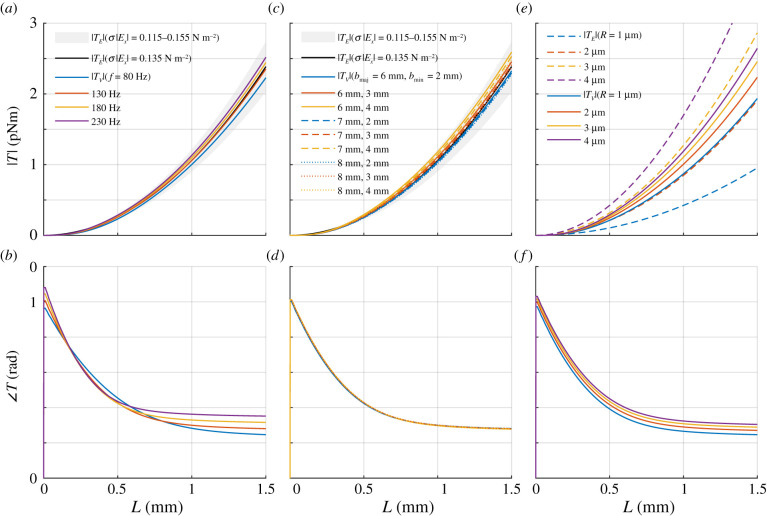
Torque amplitude |T| and phase ∠T variation with hair length L. Dependence on (a,b) frequency f, (c,d) body dimensions bmaj and bmin and (e,f) hair radius R. Results calculated with |V0| = 35 mm s−1, f = 130 Hz, bmaj = 7 mm, bmin = 2.5 mm and R = 2.5 μm unless specified. |TV| variation with f, bmaj and bmin falls within the variation of |TE| with σ|Ex| between 0.115 and 0.155 N m−2, corresponding to |Ex|=400−500 V m−1 if σ = 270 μC m−2. |TE| dependency on R is much larger than |TV|.